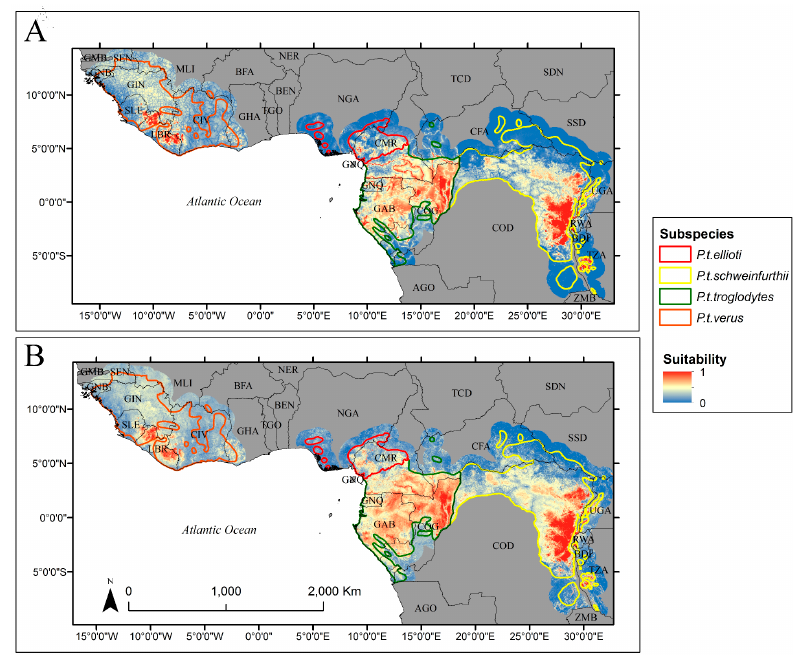
Figure 4. Spatial distribution of suitability values for 5-km resolution map ( A ), and Random Forests prediction at 30-m resolution ( B ).